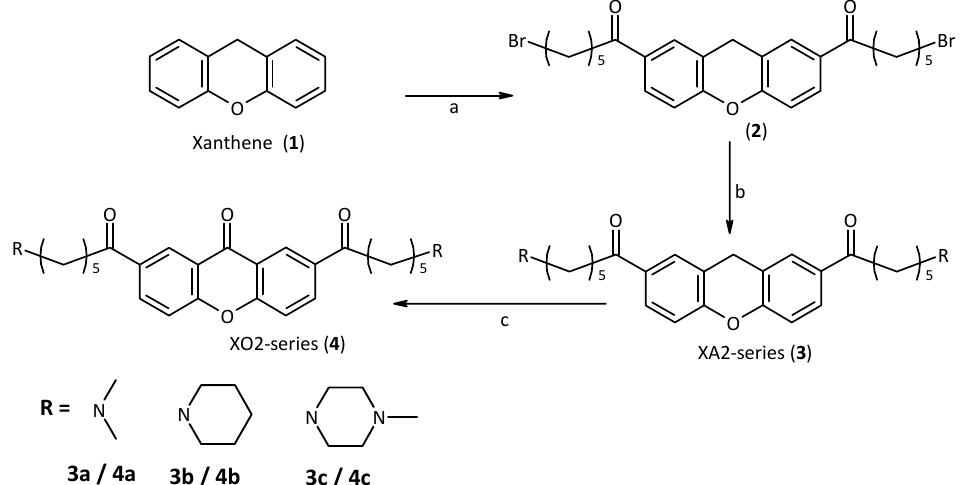
Scheme 1. Synthesis of the first series of xanthene and xanthone